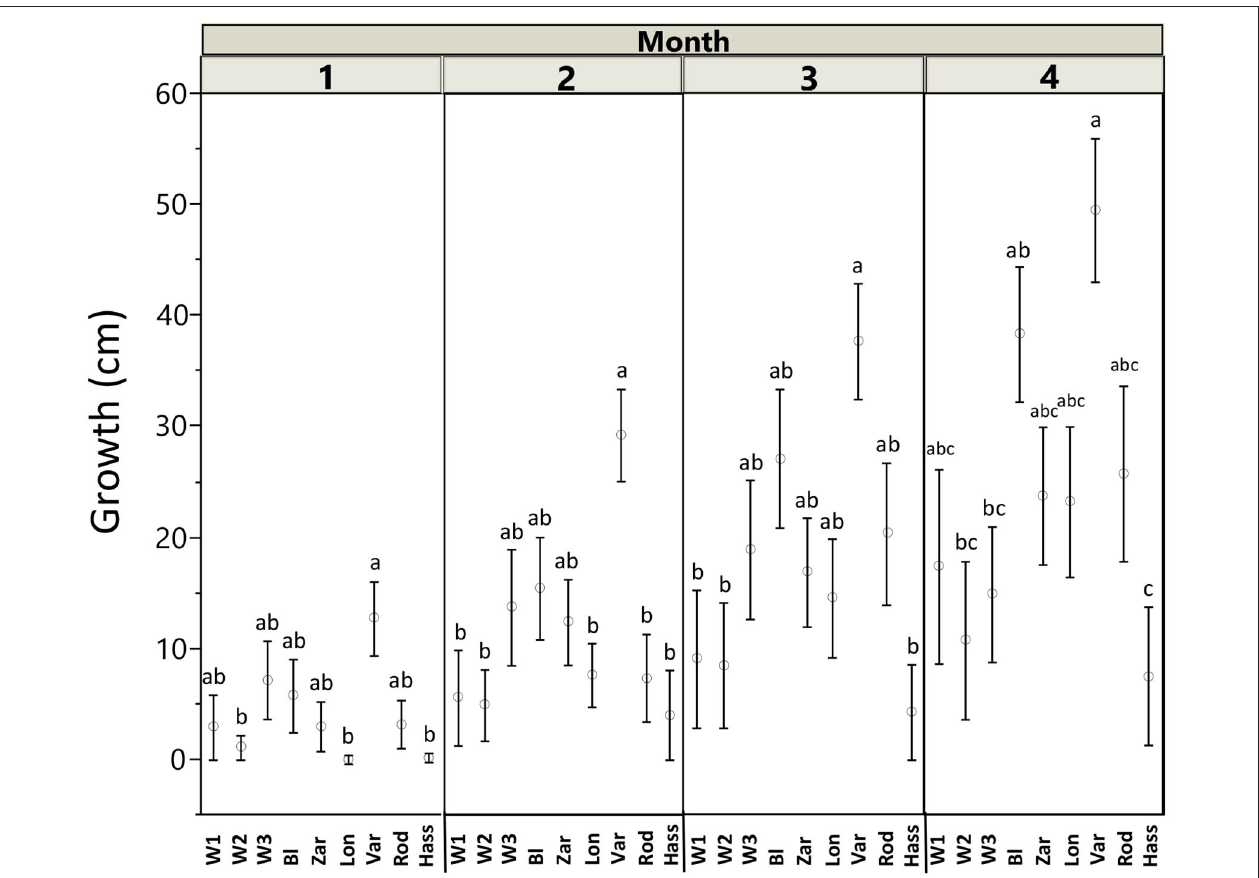
FIGURE 2 | Avocado ( Persea americana ) growth trait variation by genotype across a domestication gradient. Data points represent the size (means ± SE) of plants throughout 4 months. W1–W3 = wild populations 1–3; landraces: BL = “Blanco,” LON = “Lonjas,” ZAR = “Zarcoli,” VAR = “Vargas,” and ROD = “Rodolfo.” Different letters within each month indicate significant differences among genotypes ( P ≤ 0.05), according to Tukey’s HSD post-hoc